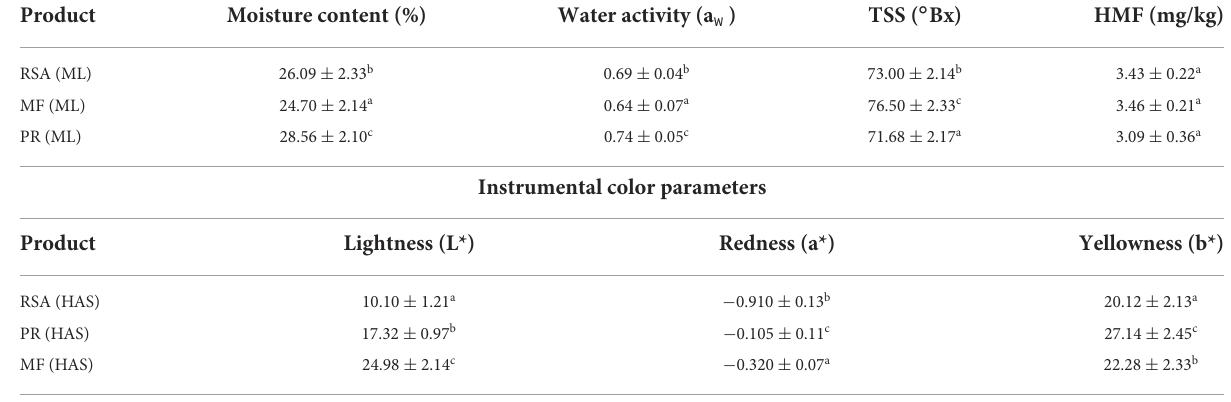
TABLE 5 Physico-chemical characteristics of honey based apple